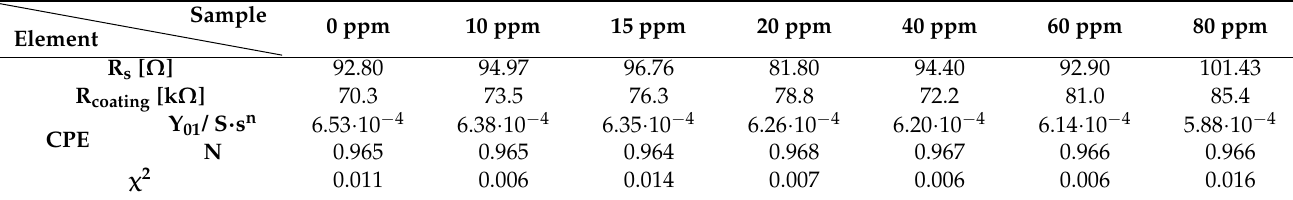
Table 1. Parameters of equivalent electrical circuits used for fitting the EIS